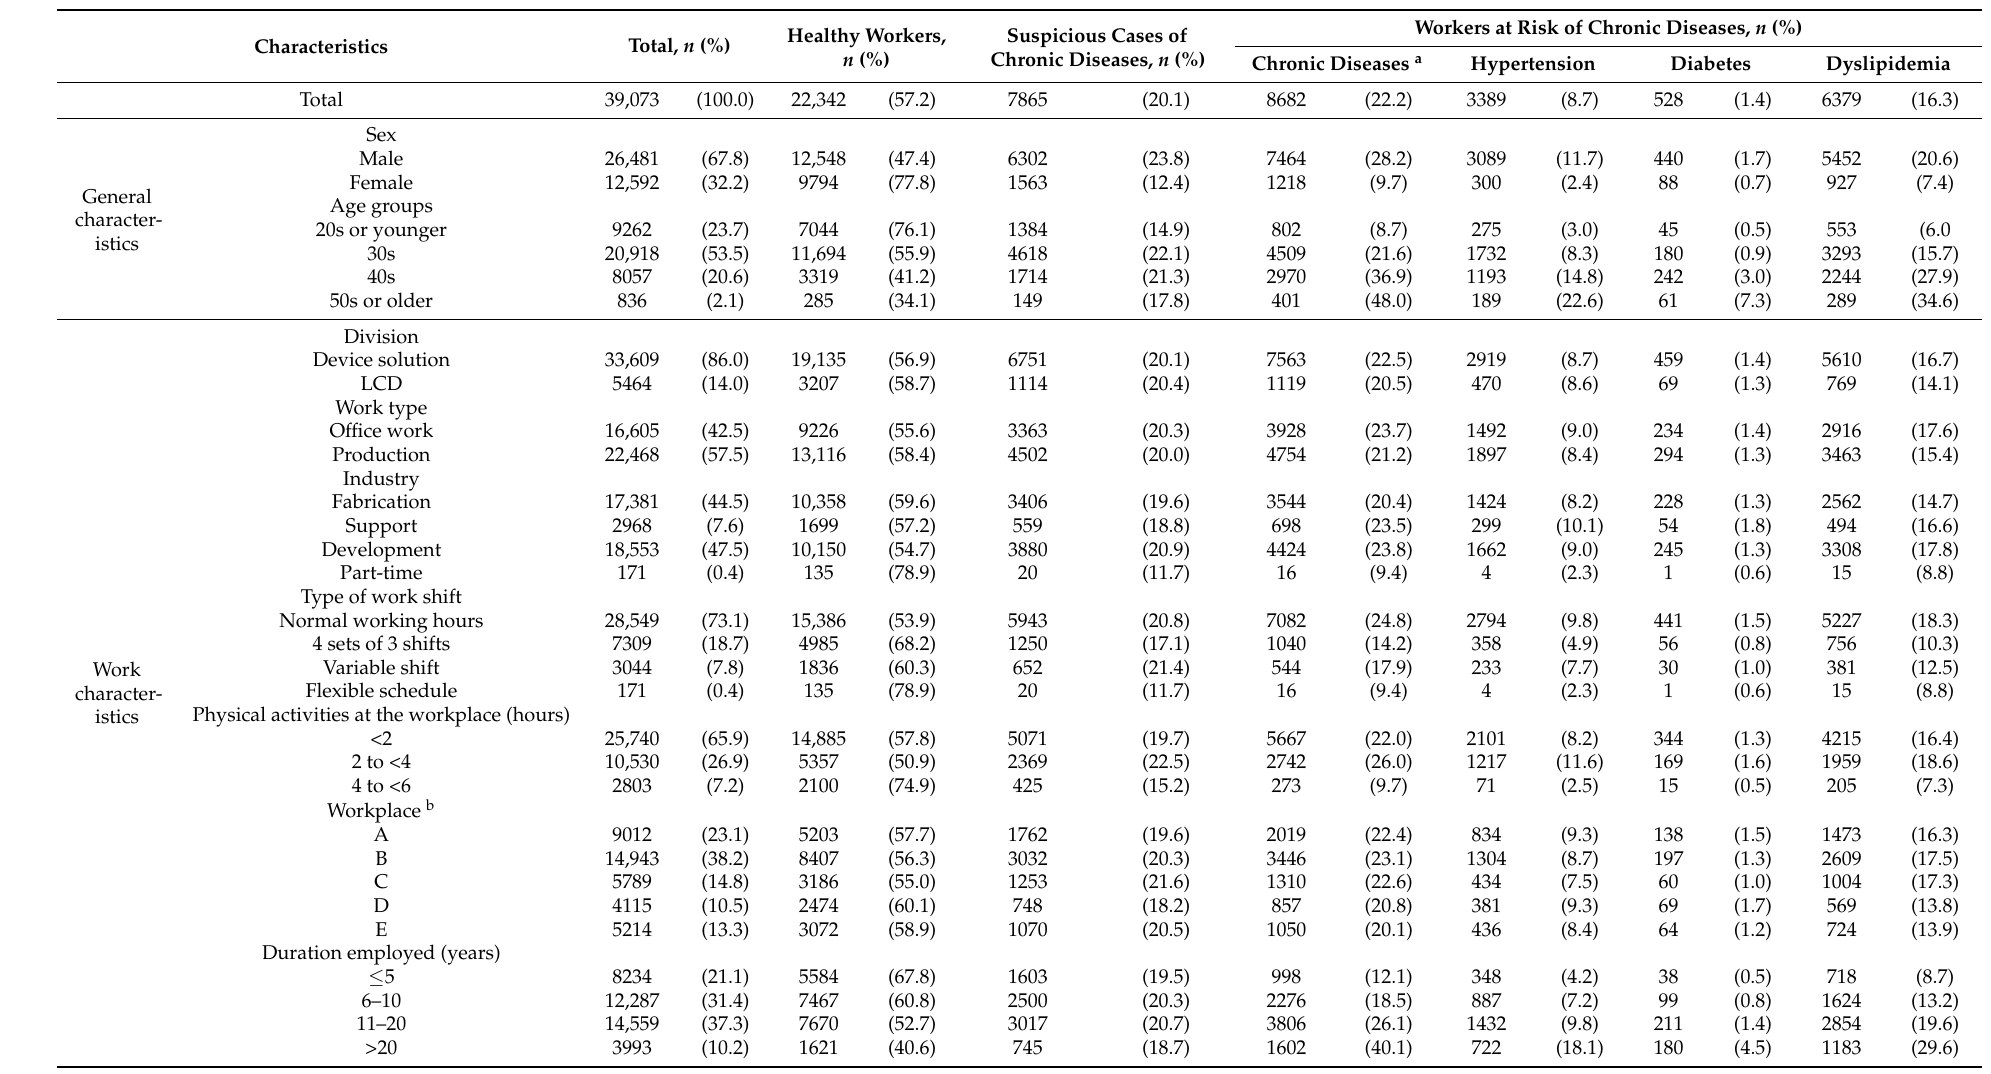
Table 1. Demographic characteristics of employees in the semiconductor/liquid crystal display (LCD) workplace with regard to risk levels of chronic